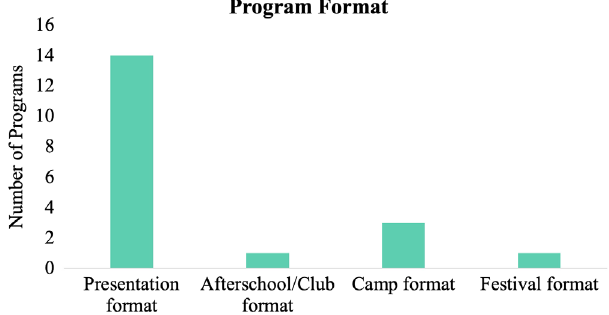
FIG. 6. Counts of the types of program format in our